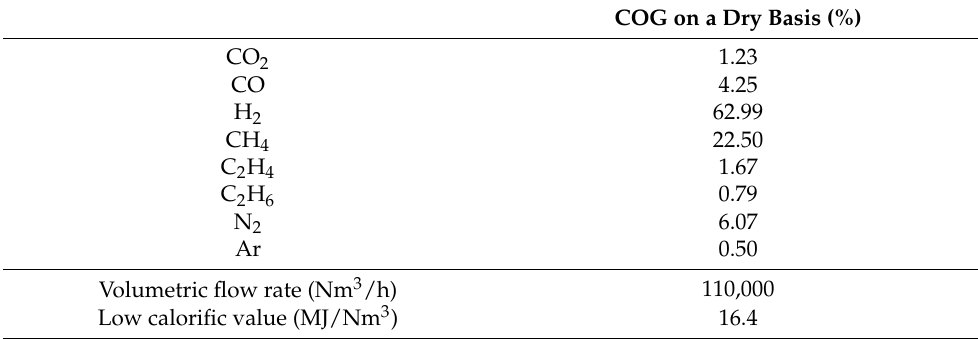
Table 1. Typical characteristics of COG; percentages correspond to molar